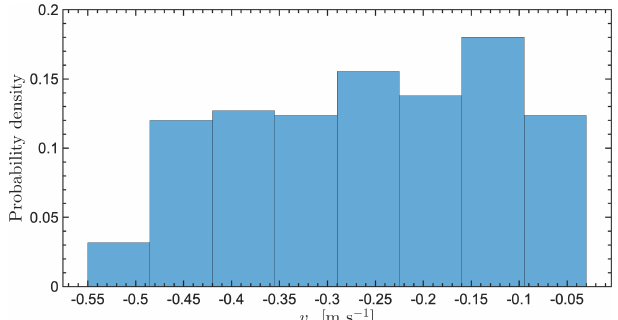
Figure A4. Simulated particle fall speed distributions for a horizon- tal wind speed of 10ms − 1